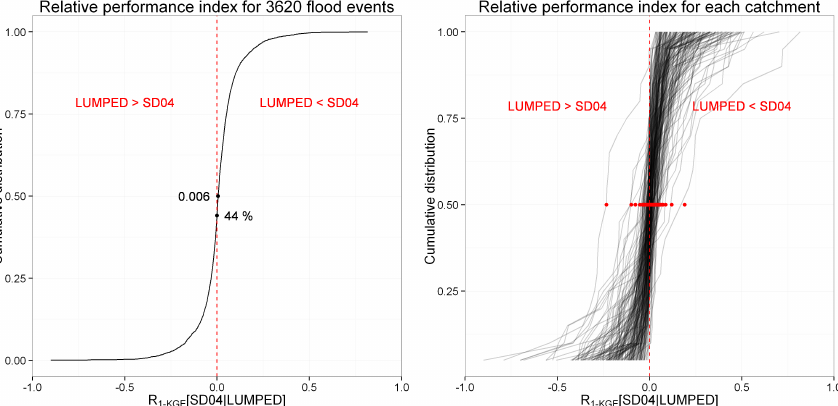
Fig. 12. Distribution of relative performance index values in validation mode of the lumped model and the SD04 semidistributed model. The distribution is drawn for the whole set of 3620 flood events (left panel) and for the 20 events of each catchment (right panel). The red points show the median values of the relative performance index for each